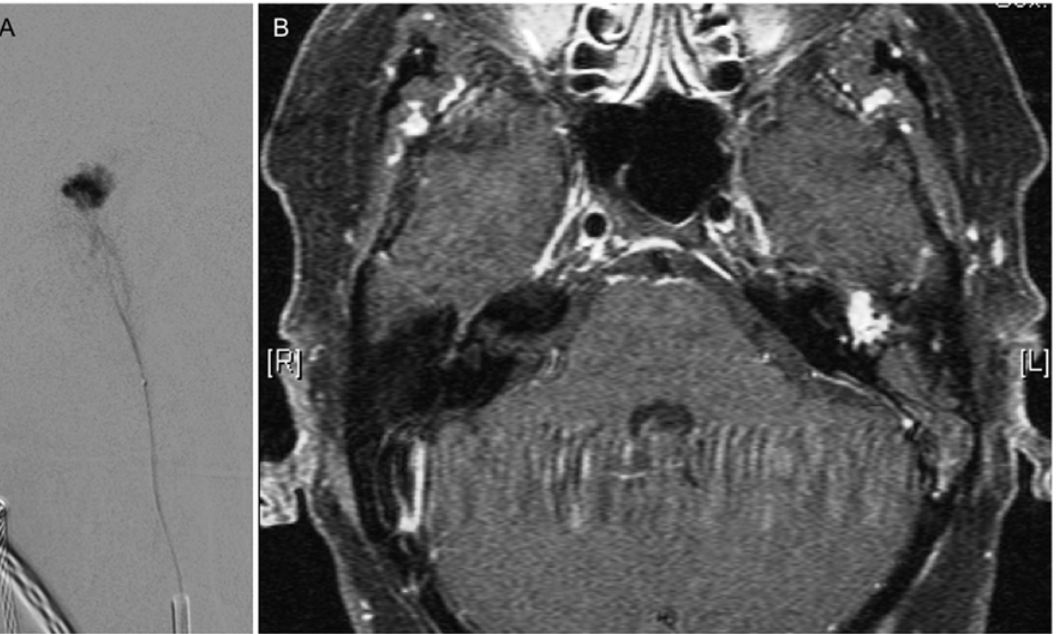
Fig 4. 42 year old patient with left sided PT for one year. A: Superselective angiographic microcatheter injection before preoperative embolization with particles. B: MRI ce-T1 fs shows a Glomus tympanicum paraganglioma: enhancing mass in loco typico. doi:10.1371/journal.pone.0117814.g004 4 patients. Two patients had an AVM supposed to be the cause for PT. Carotid-cavernous fis- tulae were seen in two patients. In one patient an aneurysm of the internal carotid artery was the reason for PT, which vanished after coil embolisation. Stenosis of the internal carotid artery was the only detecTable reason of PT in one patient. Extracranial arteriovenous fistulae were found in three patients (Table 1). No morphological correlate for PT was identified on MRI of 17 patients and DSA did not reveal any further pathology in these patients.